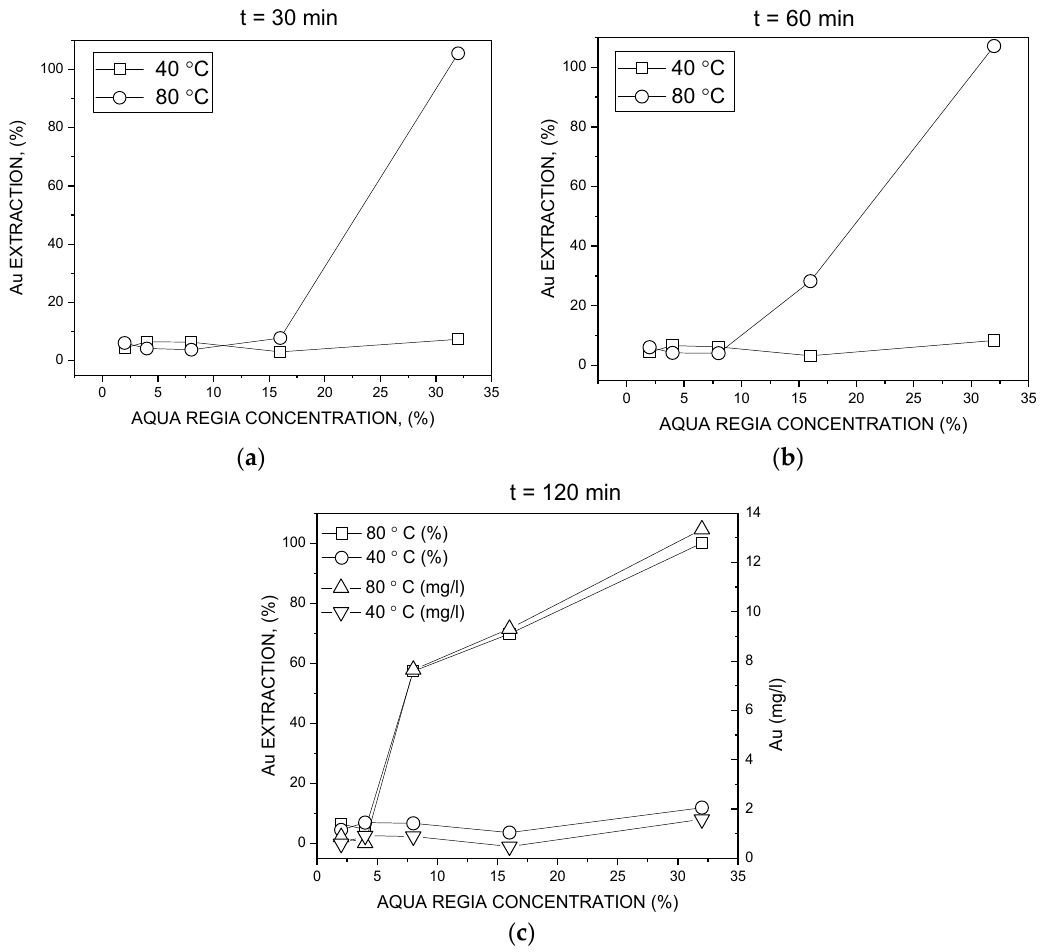
Figure 6. The extractions of gold at ( a ) t = 30 min; ( b ) t = 60 min; and ( c ) t = 120 min.